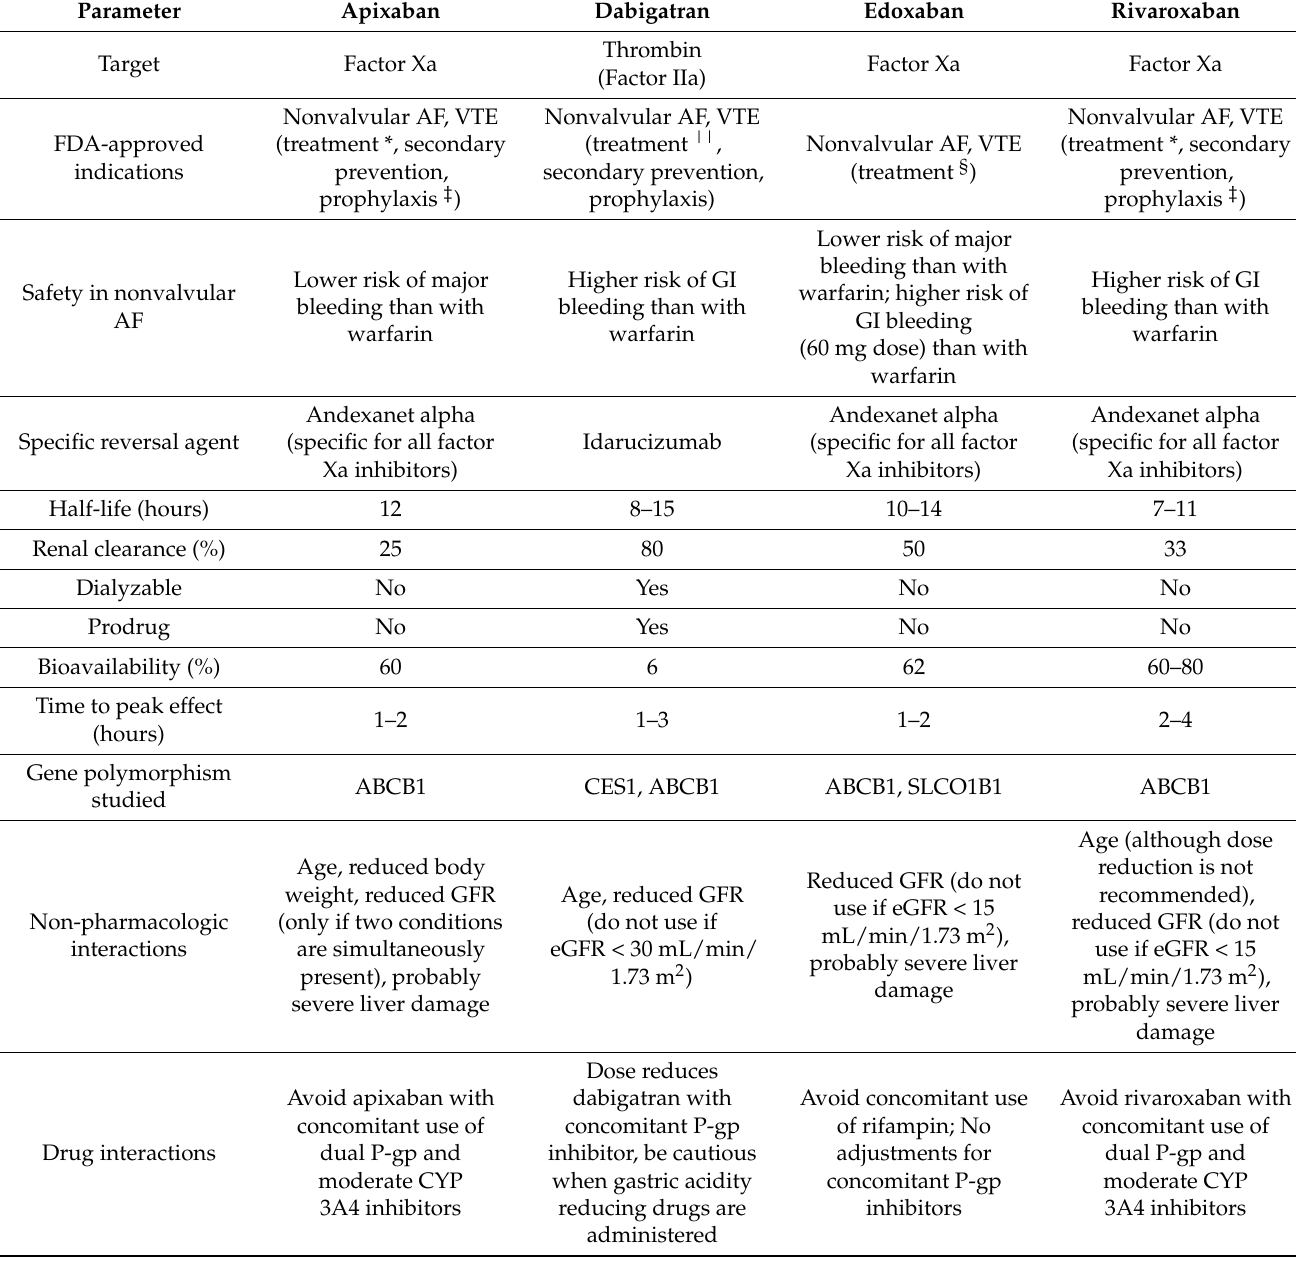
Table 1. Direct oral anticoagulants: targets, indications, and